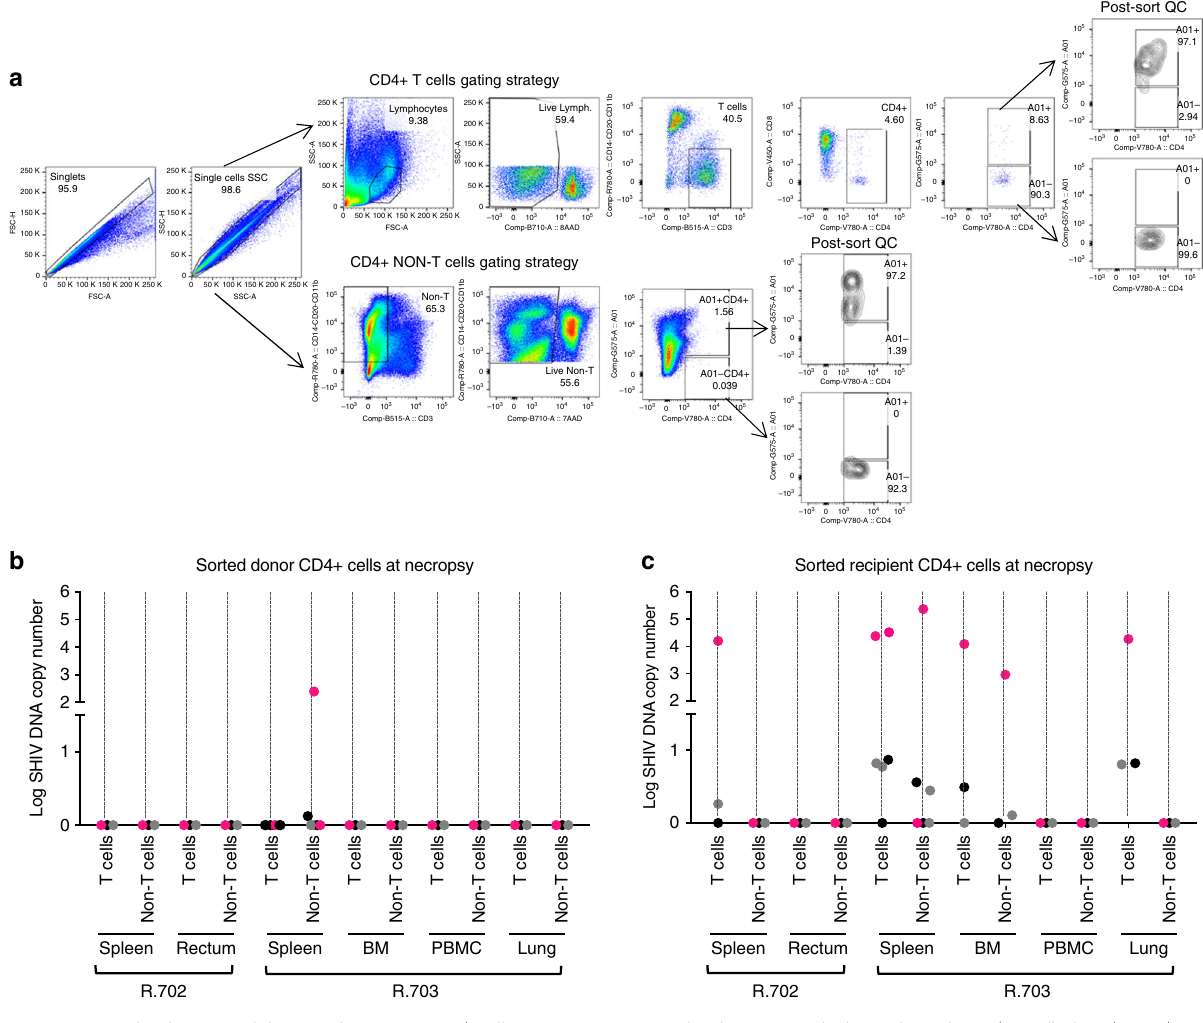
Fig. 7 SHIV-C DNA levels in sorted donor and recipient CD4 + cells. a Gating strategy utilized to sort-purify donor-derived CD4 + T cells (A01 + CD3 + CD4 + ), donor-derived CD4 + non-T cells (A01 + CD3 - CD4 + ), recipient-derived CD4 + T cells (A01 - CD3 + CD4 + ), and recipient-derived CD4 + non-T cells (A01 - CD3 - CD4 + ). Following the sorting of donor b and recipient c cells, gDNA was extracted, and SHIV DNA copy number per 10 µ L of reaction was measured by qPCR with GAG-speci fi c primers in duplicate. The replicate PCR results are shown as gray and black dots (two replicates for each sample with the exception of R.703 spleen, for which two separate samples were analyzed, thus 4 PCR replicates are shown). The raw qPCR results were also averaged and normalized to SHIV DNA copy number per 1 × 10 6 CD4 + cells with the aid of a genomic DNA standard (macaque RNaseP p30, MRPP30) 35 , which are represented as pink